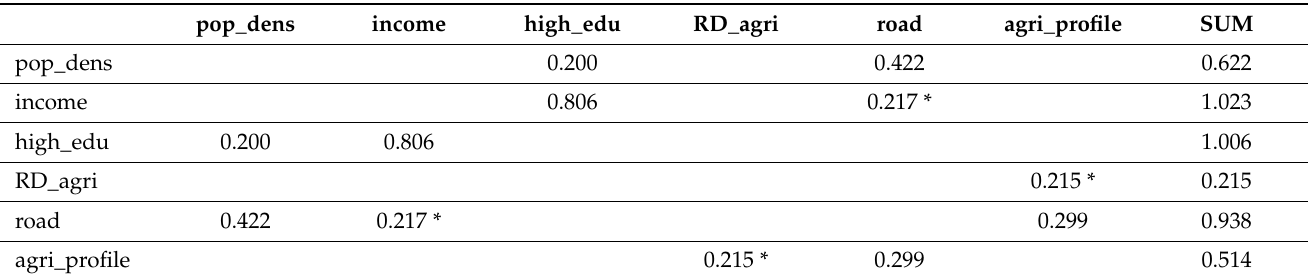
Table 3. Relevance of the analytical variables according to the correlation coefficients. Values with (*) correspond to the negative correlations that were turn into positive values to facilitate measurement; our own